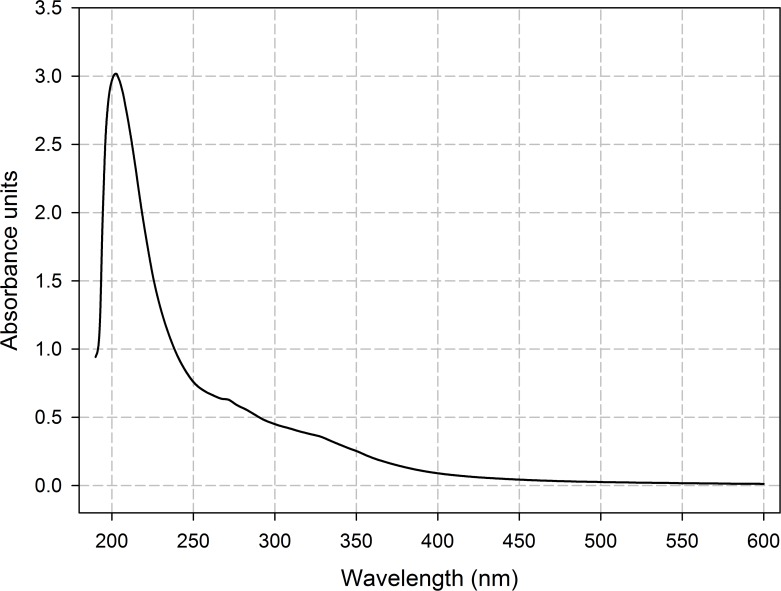
Absorption spectrum of Arnica m. 1c used as starting material.